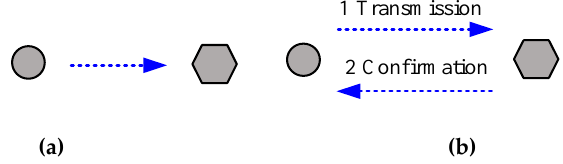
Figure 10. Active node transmission modes: ( a ) open-loop mode, ( b ) closed-loop mode.